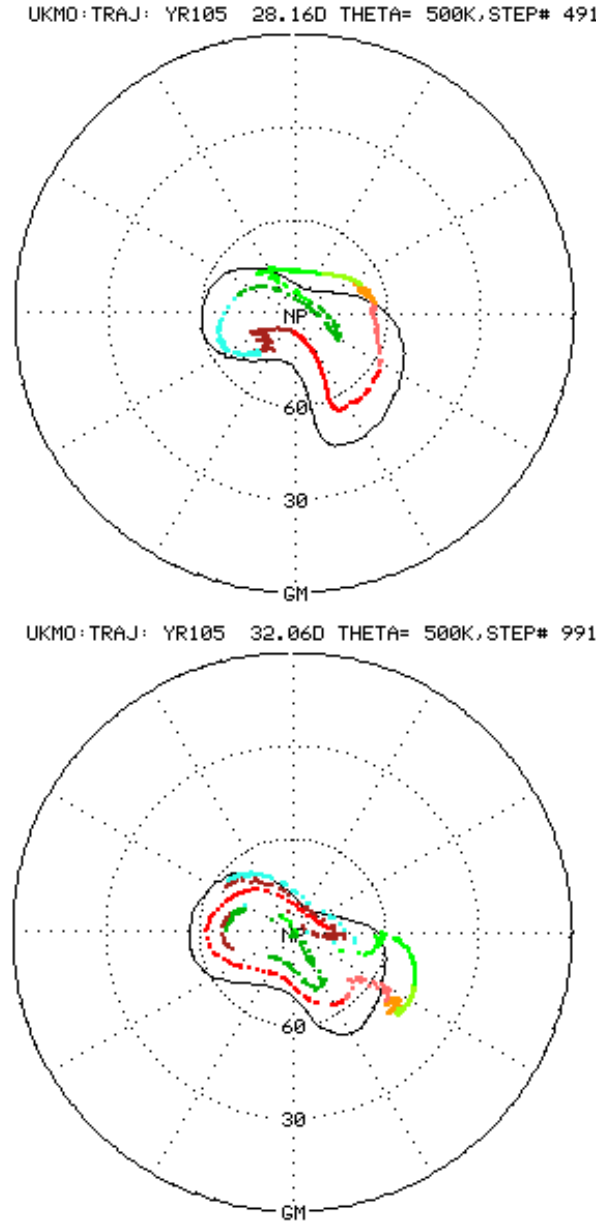
Fig. 12. Trajectory analyses at 500K/ ∼ 20km for two days (28 January and 1 February) within the 1 February temperature/vortex event of winter 2004/2005. Air parcels were released at the 70 ◦ N circle on 24 January: burgundy red at 16 ◦ E and middle/bright green at 253 ◦ E. The vortex edge (from the Q-diagnostic) is shown by the black